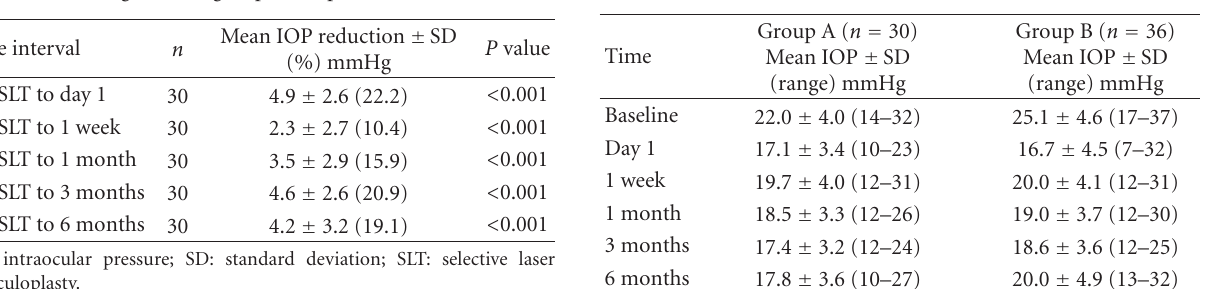
Table 2: IOP reduction from baseline at each time interval in pseudoexfoliation glaucoma group (Group A).